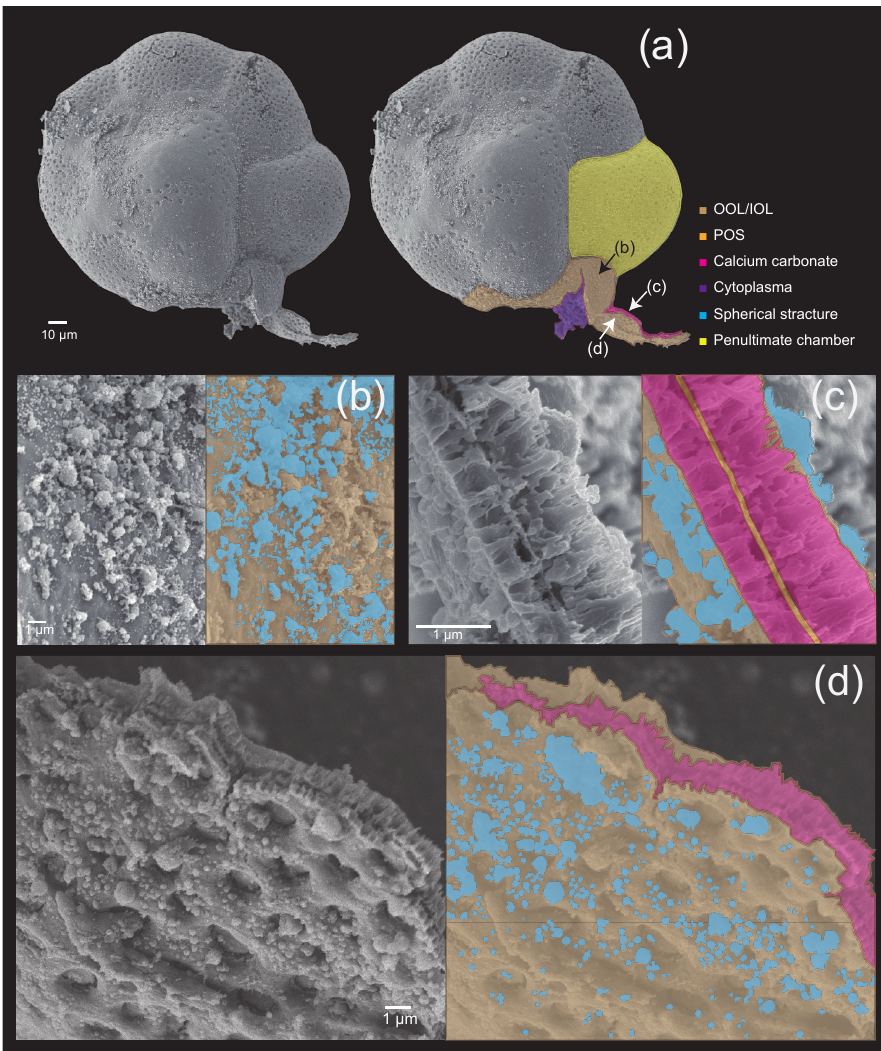
Figure 5. Microstructures during the late stage of the chamber formation shown by SEM images on the left, supplemented by schematic explanation on the right. (a) Overview of the dorsal side of a specimen, with the newly forming chamber on the bottom. (b) Magnified image of the OOL seen from the outside. (c) Image showing a cross section through the forming chamber wall. (d) A magnification of the IOL seen from the inner side, showing pores and lots of spherical structures. Colour legend: brown = OOL/IOL; orange = POS; pur- ple = pseudopodia/cytoplasm; light green = pore funnel on the OOL; green = pore plate; magenta = calcium carbonate; blue = spherical